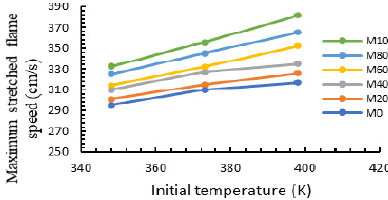
Figure 10. Variation of max. S n versus initial temperature for different methanol blending ratios.